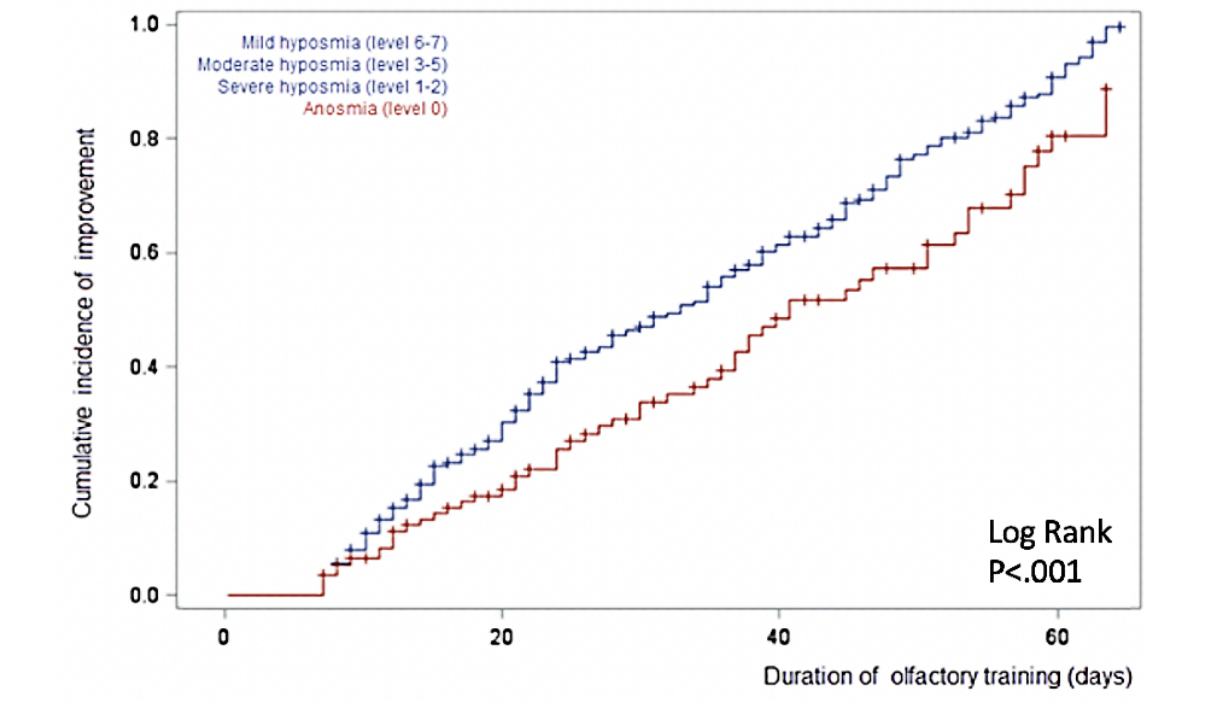
Figure 2. Cumulative incidence of olfactory improvement according to the olfactory training durations of patients with anosmia and hyposmia. The data of patients with mild, moderate, and severe hyposmia were pooled in the blue curve.